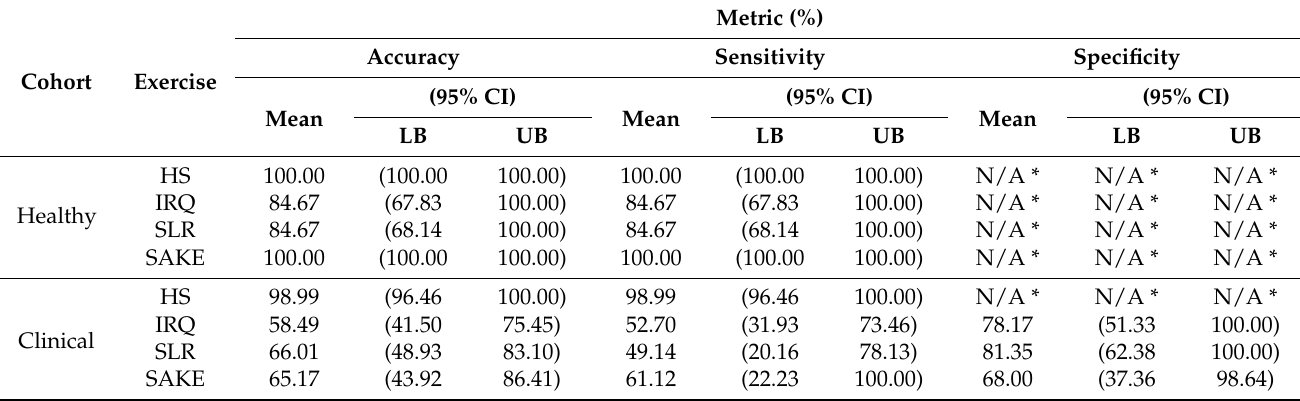
Table 5. Classification performance following manual segmentation of test